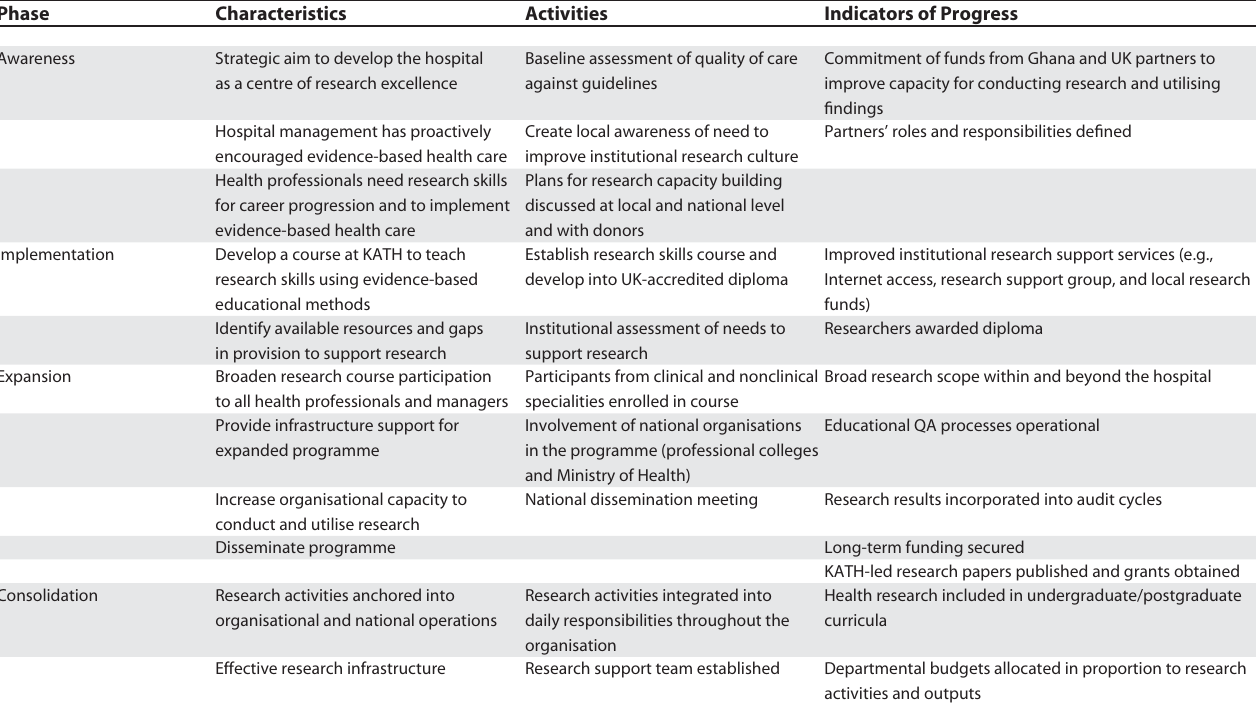
Table 2. Adaptation of the Framework into a Tool That Was Relevant to the Needs of